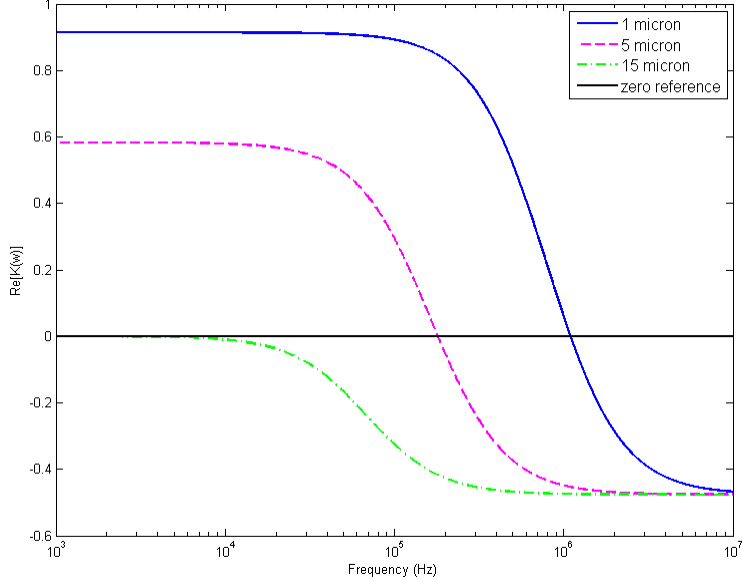
Figure 3. Re[ K ( ω )] versus frequency for 1, 5 and 15 μ m polystyrene